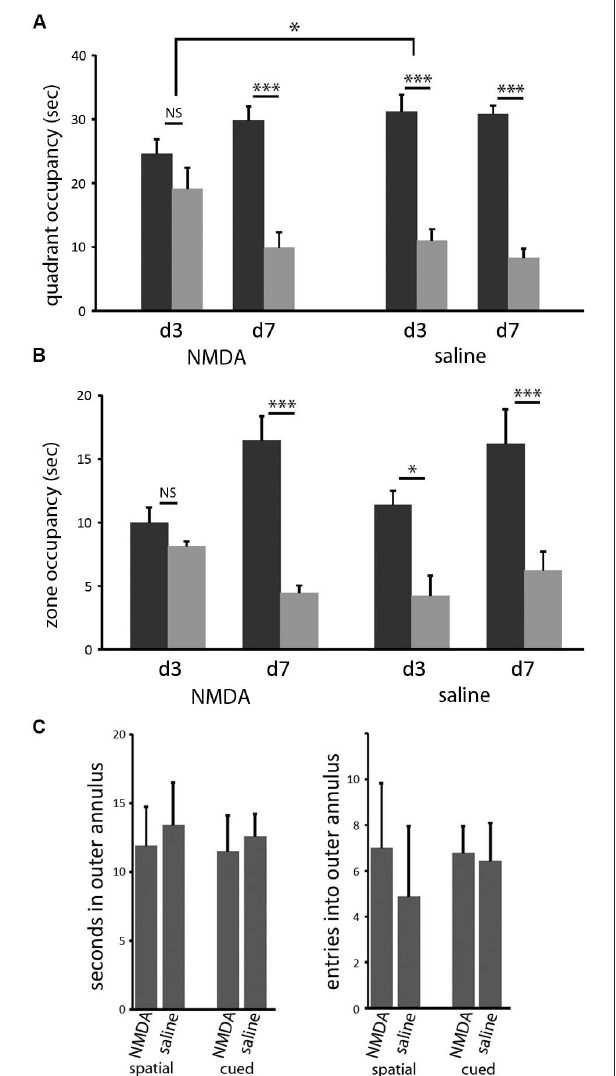
FIGURE 3 | DMS lesions delay spatial learning without affecting asymptotic performance. (A) Control mice ( n = 8) had acquired the spatial task by the end of the third day of training, as indicated by their bias towards the goal cue quadrant in the probe ( p < 0.005); in contrast, mice with dorsomedial striatal lesions ( n = 8) did not show a significant bias towards the goal quadrant. This effect of lesion was significant ( p < 0.05). In contrast, both groups showed clear spatial learning on day 7 (both: p < 0.005), with no significant difference between groups. Similar effects were seen when probe trial data were analyzed by goal zone occupancy or proximity (not shown). (B) The same pattern was seen when probe trial performance was quantified by occupancy in a circular target zone around the goal and lure cues. (C) Lesions did not cause any increased thigmotaxis in either task on day 3. There was no significant effect of either lesion or task on either occupancy in or entries into the outer annulus during exploration. * p < 0.05; *** p <